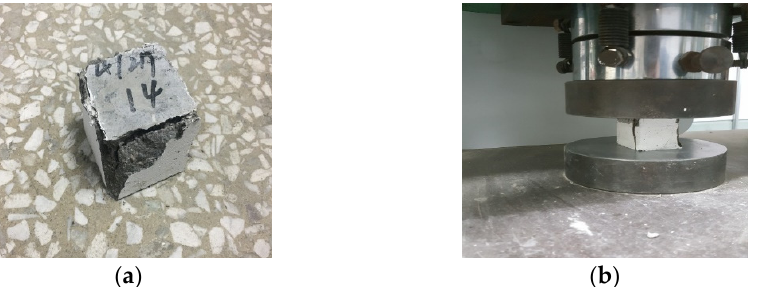
Figure 4. Compressive strength re-load test: ( a ) fracture specimen for re-load test, ( b ) re-load test of fractured specimens after the healing period.